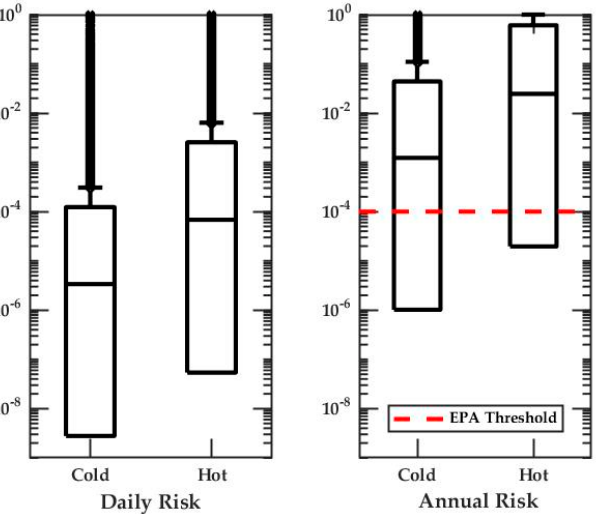
Figure 4. Boxplots of daily and annual infection risk based on aerosol inhalation of Legionella - contaminated cistern water during cold and hot shower scenarios. The median is shown as the mark inside the box, 25th and 75th percentile values are the bottom and top edge of the box,